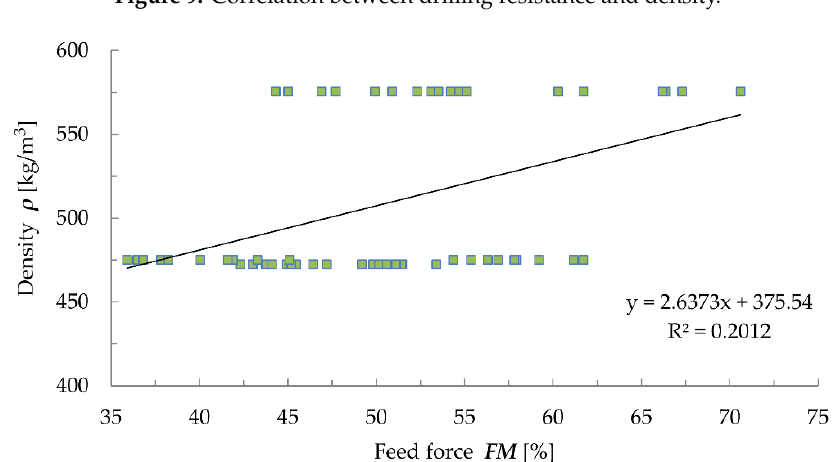
Figure 10. Correlation between feed force and density.